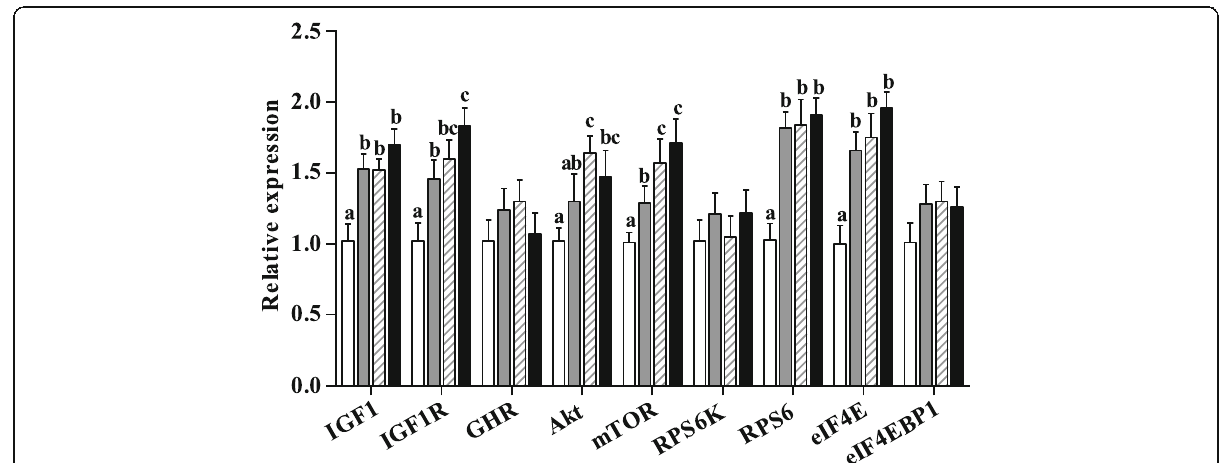
Fig. 2 Effects of the level of nutrient intake on mRNA abundance of growth-related genes in psoas major muscle of pigs with different birth weight. Values are means, with their standard errors represented by vertical bars ( n = 6 for each group). Mean values with different letters (a, b, c) were significantly different between four groups ( P < 0.05). , IUGR/ANI; , NBW/ANI; ,